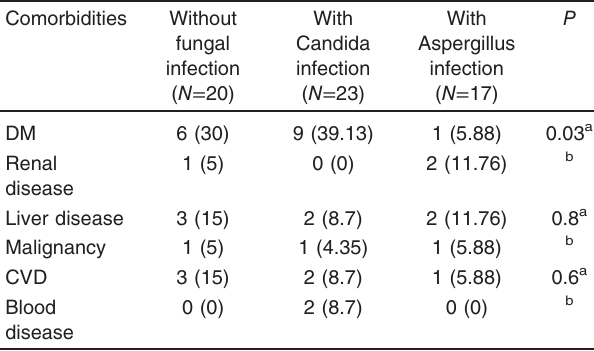
Table 3 Comorbidity impact in patients with fungal infections Comorbidities